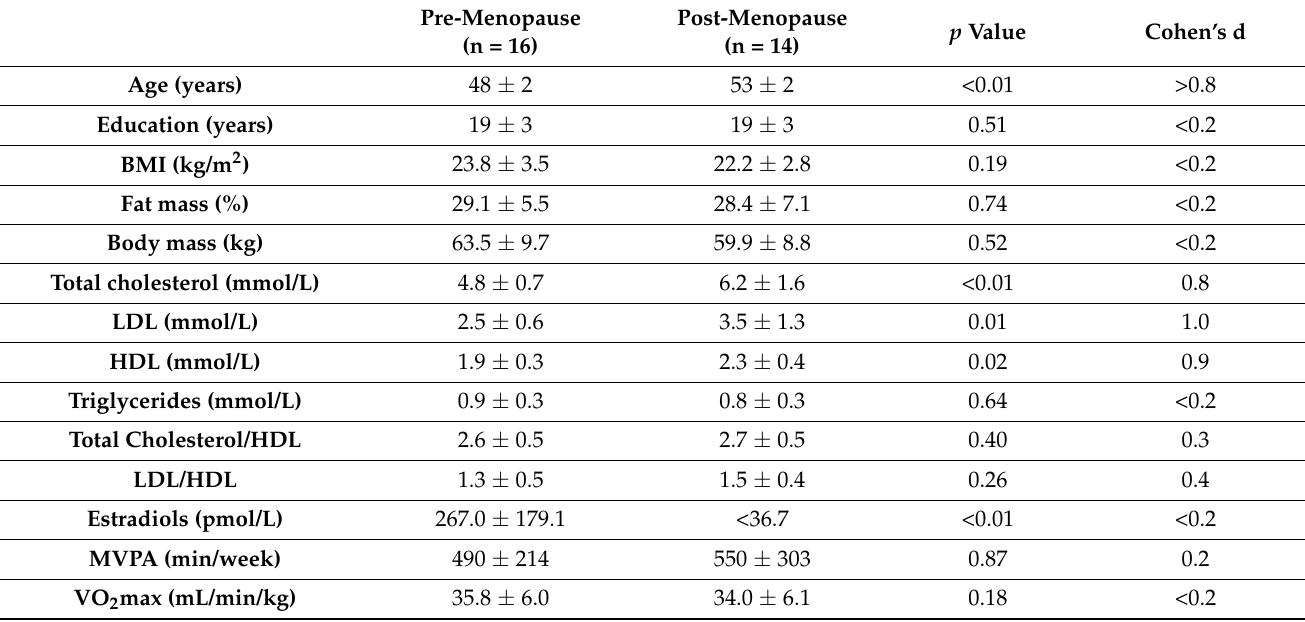
Table 1. Participant